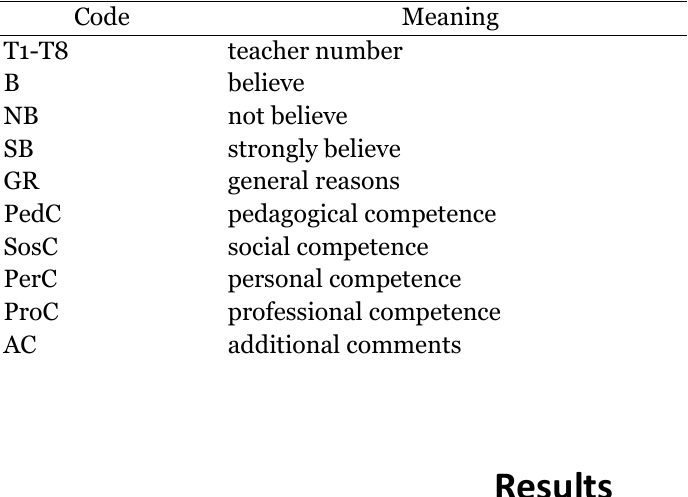
Codes Used to Categorise Interview Participants’ Comments